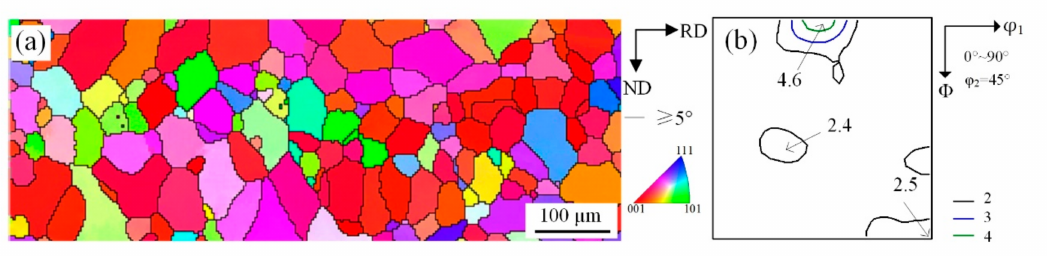
Figure 9. EBSD IPF map ( a ) and ϕ 2 = 45 ◦ section of ODF (calculated from left IPF map) ( b ) of 0.35 mm annealed sheet.